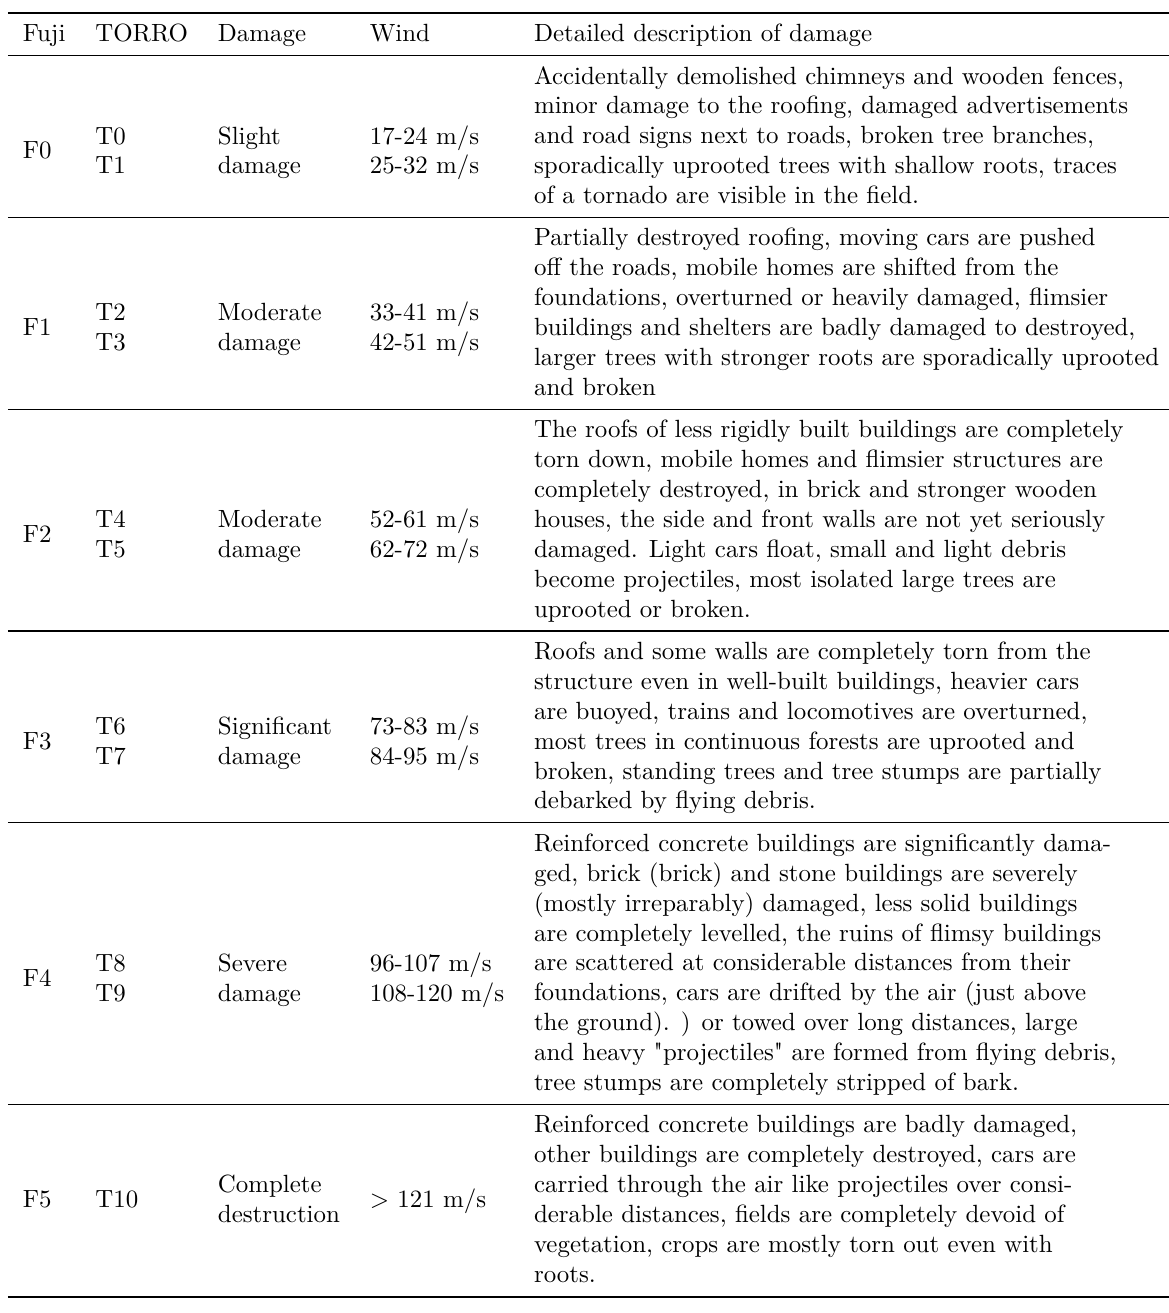
Table 1. Tornado intensity scales of Fuji and